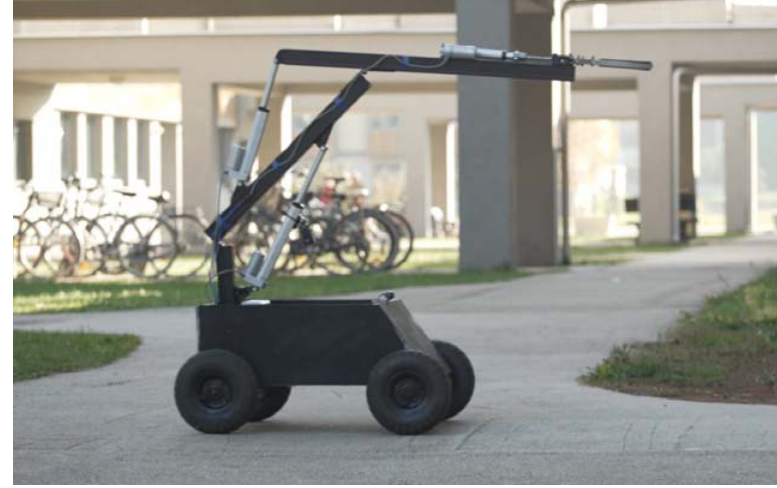
Figure 1. Design of the robot Table 2. List of components built in physical steel